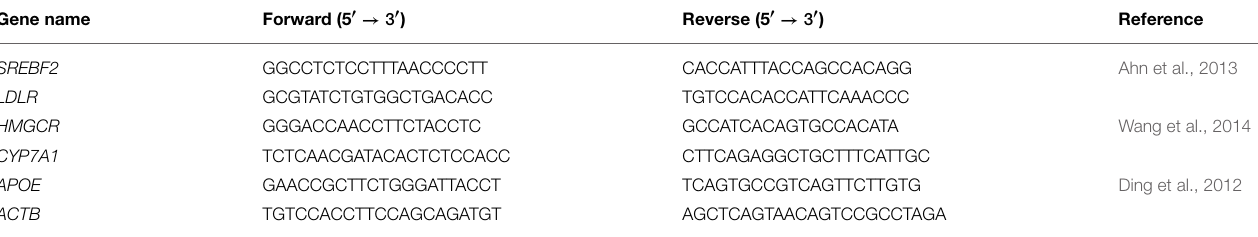
TABLE 1 | The primer sequences used for quantitative real-time